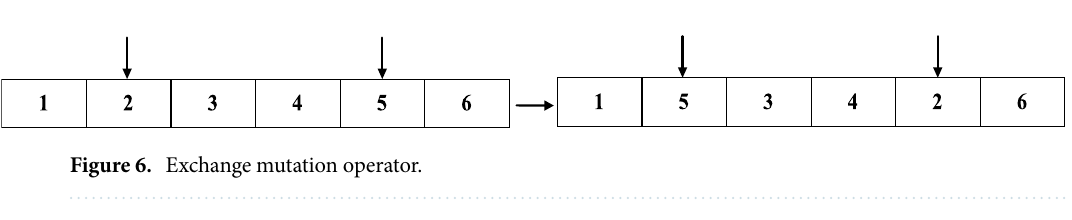
Figure 5. PBX crossover operator.